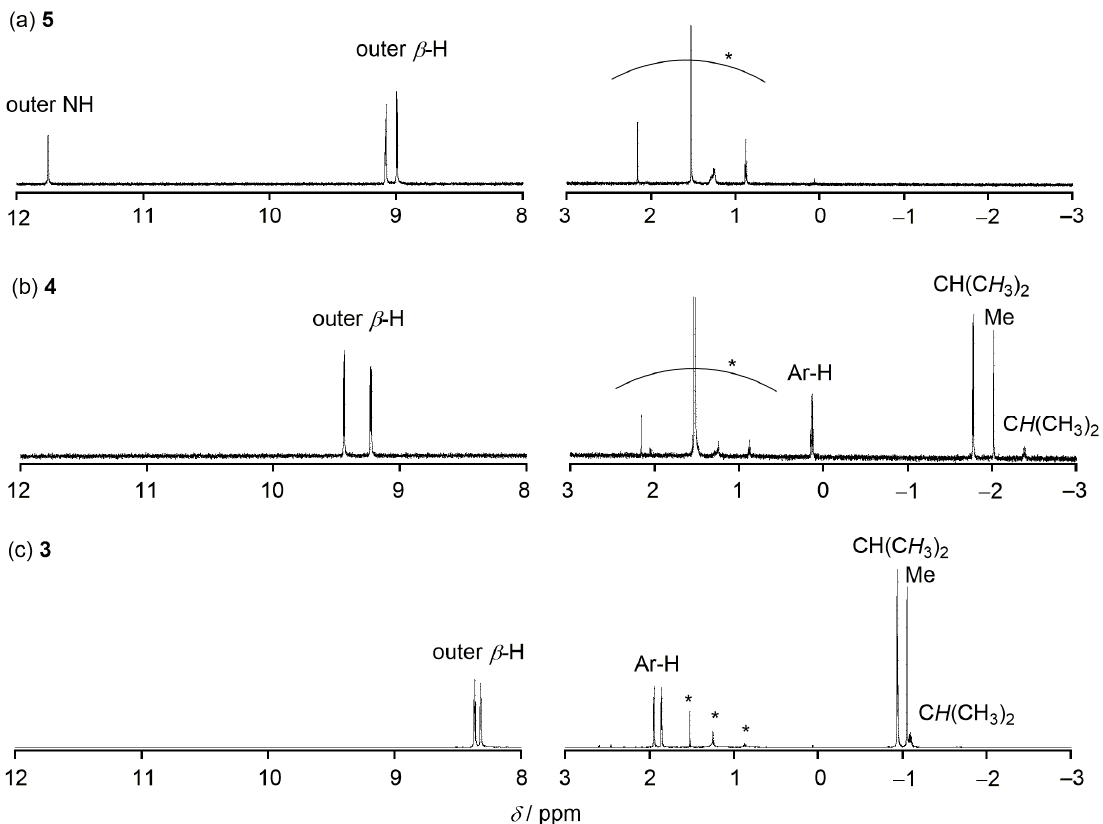
Figure 3. 1 H-NMR spectra of ( a ) 5 , ( b ) 4 and ( c ) 3 in CDCl 3 at room temperature. Asterisks mean residual solvent and impurity.